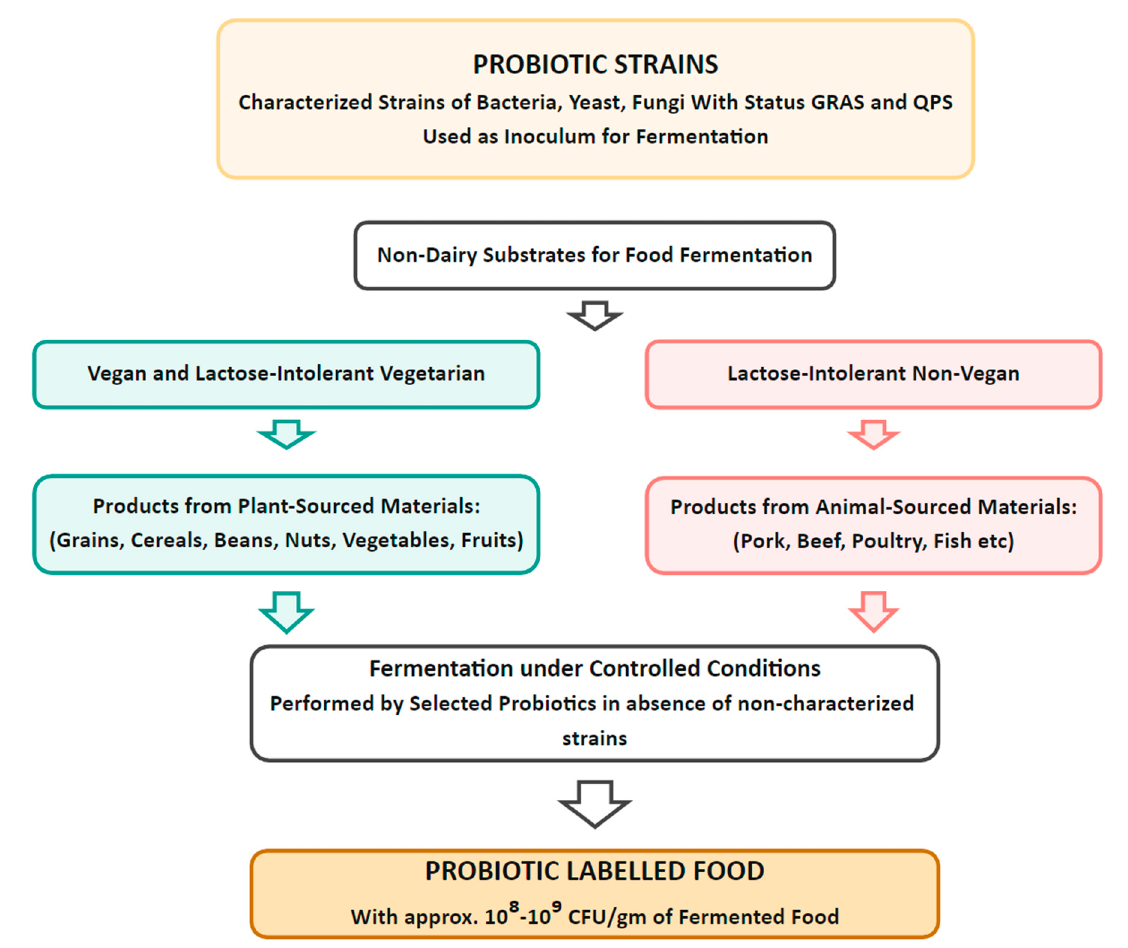
Figure 1. Probiotic strains for non-dairy-based fermented food for vegans and lactose-intolerant vegetarians or non-vegans. GRAS—generally regarded as safe; QPS—qualified presumption of safety. CFU/gm—colony forming unit or viable cells of probiotic strain present in each gram (weight of product).